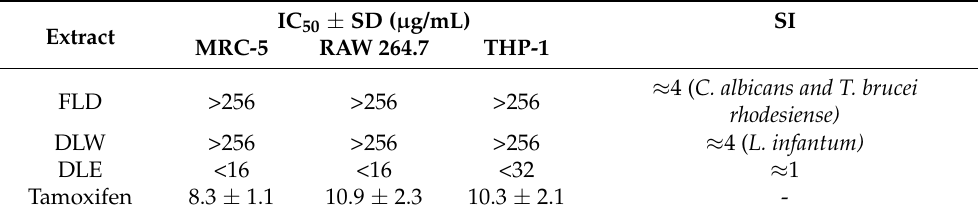
Table 5. Cytotoxicity and Selectivity index (SI) of extracts from Plectranthus neochilus leaves growing in Santiago de